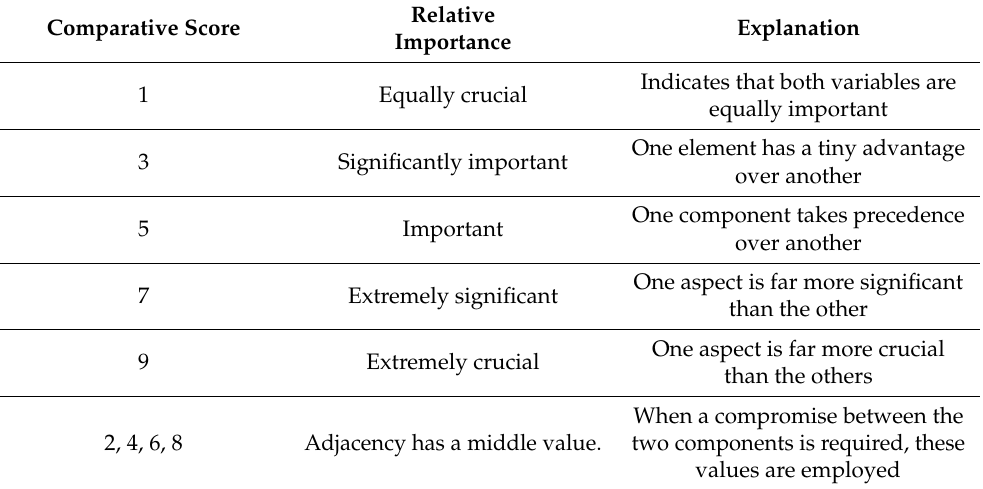
Table 2. Criteria for scoring in the judgment